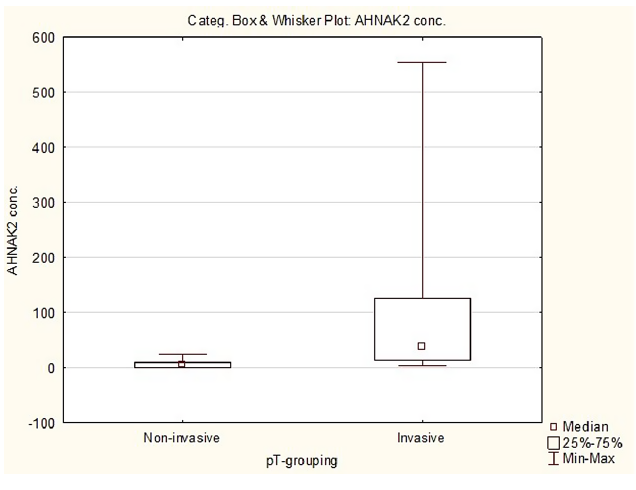
Figure 2. Boxplot comparing AHNAK2 urinary levels in patients with non-invasive bladder cancer (pTa/PUNLMP, pTis) and invasive (pT ≥ 1) bladder cancer.